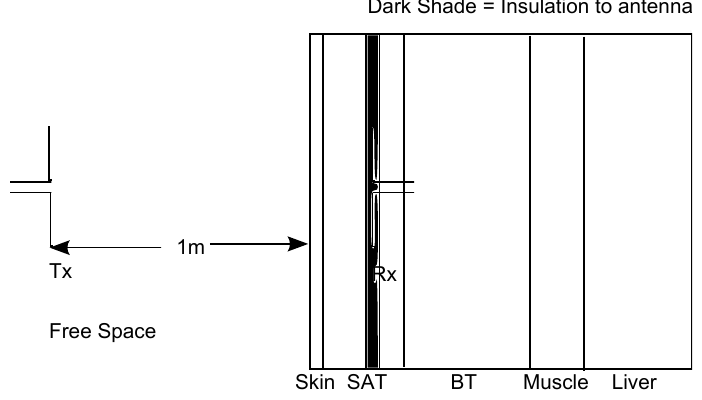
Figure 2. Air to layers equivalent to human frontal thorax. Table 1. Values of (cid:15) and σ [ S/m ] r